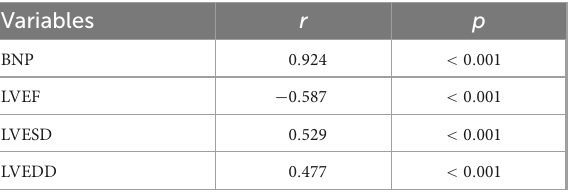
TABLE 3 Spearman correlation analysis of phenylacetylglutamine and the clinical data. Variables